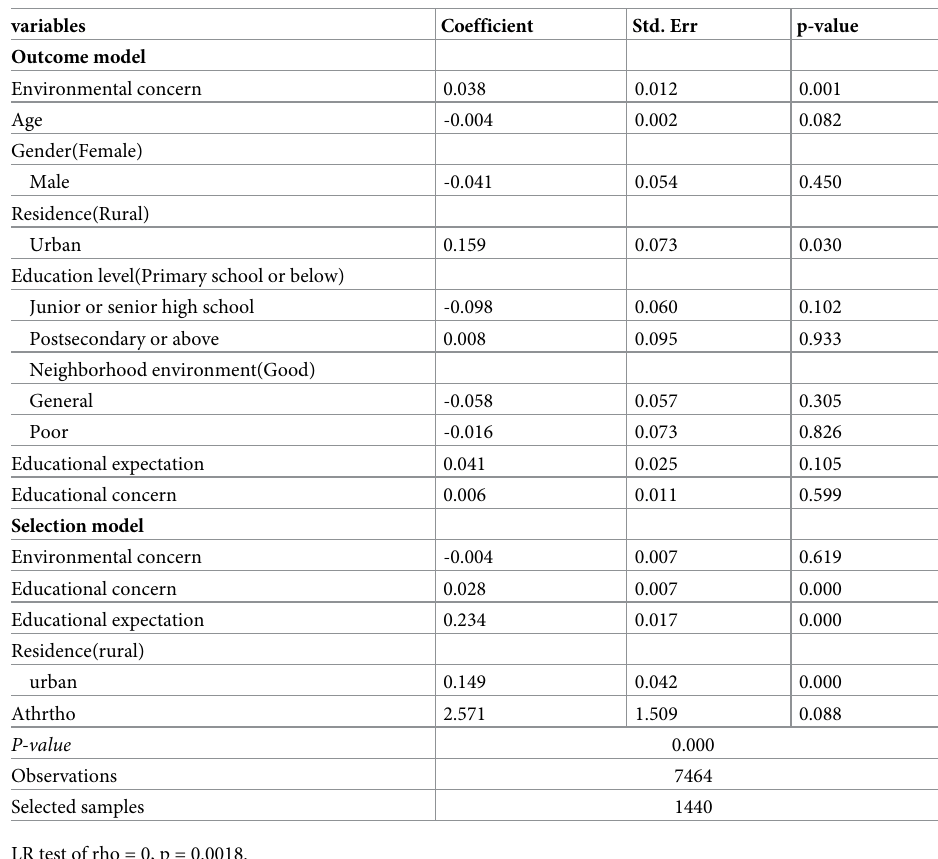
Table 3. Heckman probit estimates for expected educational level of sending children to study abroad.